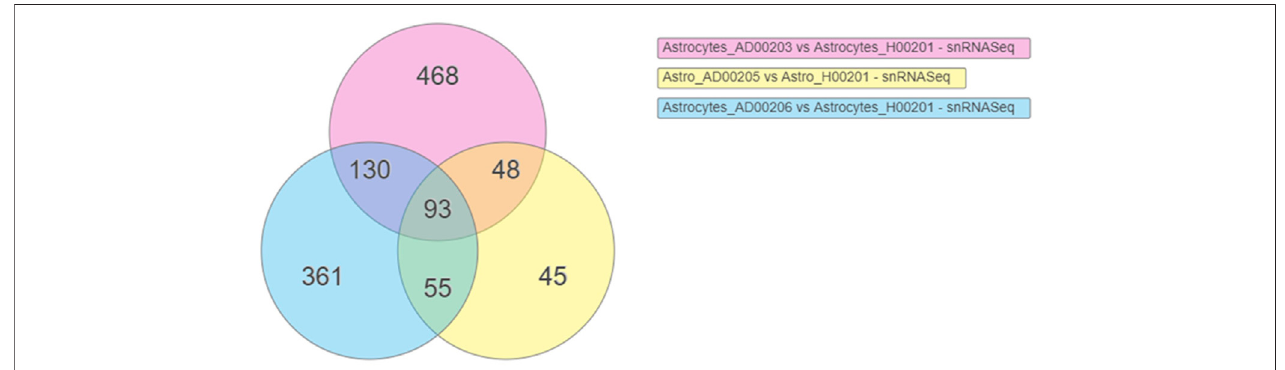
FIGURE 2 | Venn diagram showing the DEGs obtained using the scREAD analysis of snRNASeq data from astrocytes of AD groups (AD00203, AD00205, and AD00206) compared to astrocytes of the healthy control group (AD00201) were 739, 241, and 639 respectively after fi ltering with a p -value cut off of 0.05 and log2 fold change (Log2Fc) of ± 0.3. Further analysis of DEGs using iPathwayGuide software showed that 93 DEGs were commonly regulated in all the disease groups.